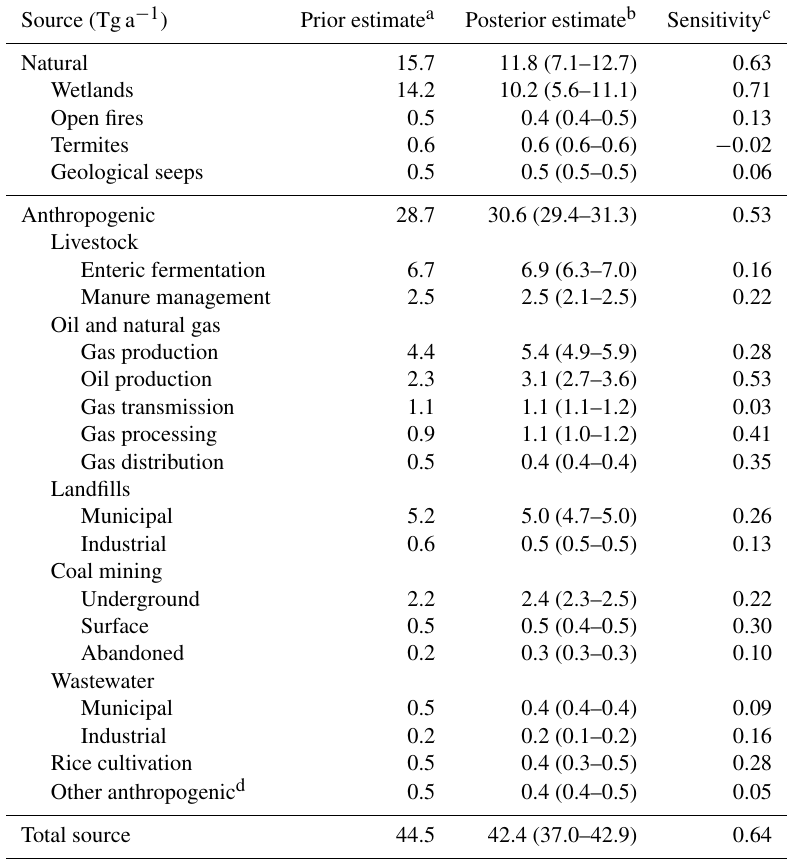
Table 2. Mean 2010–2015 methane emissions in the contiguous US